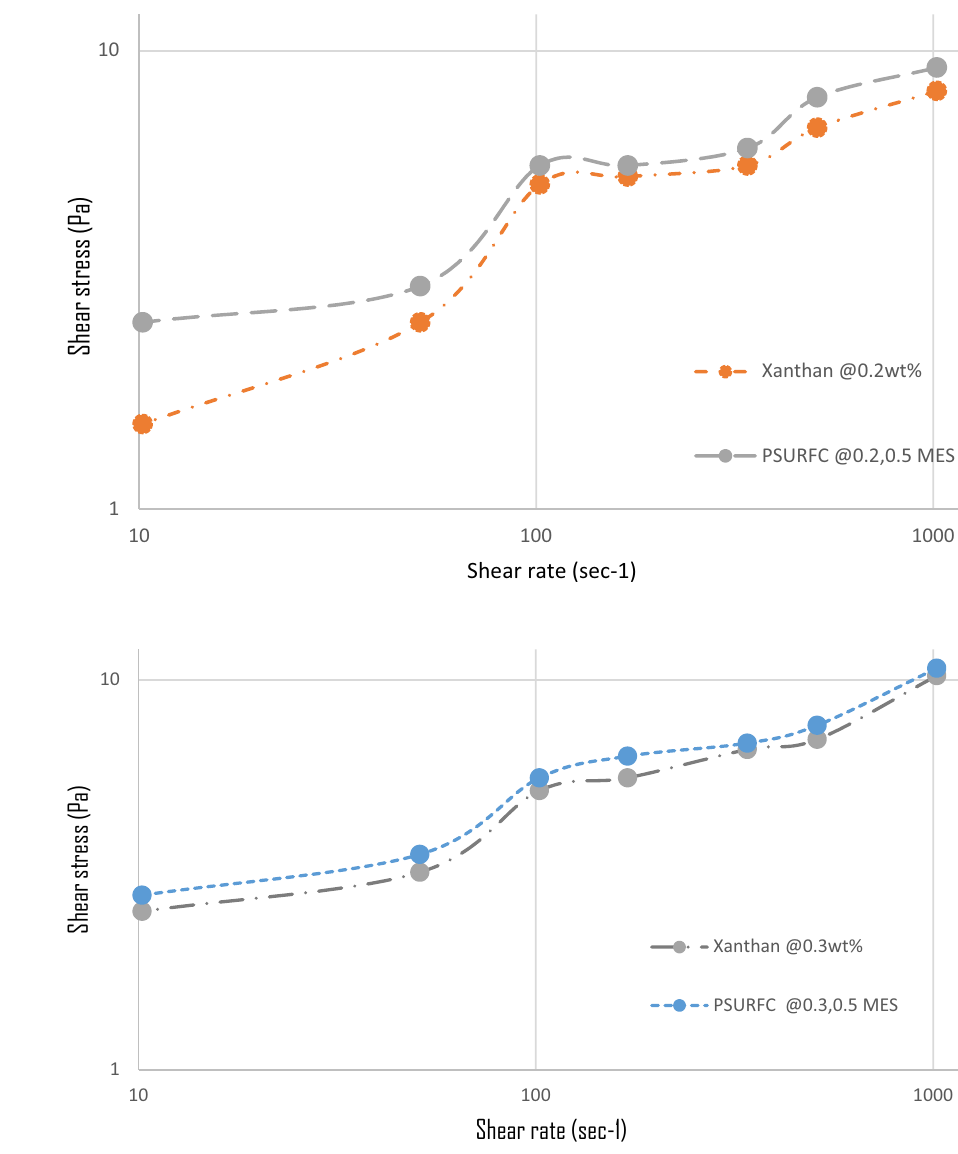
Fig. 3 Shear stress vs. shear rate analysis for Xanthan gum. Experimental